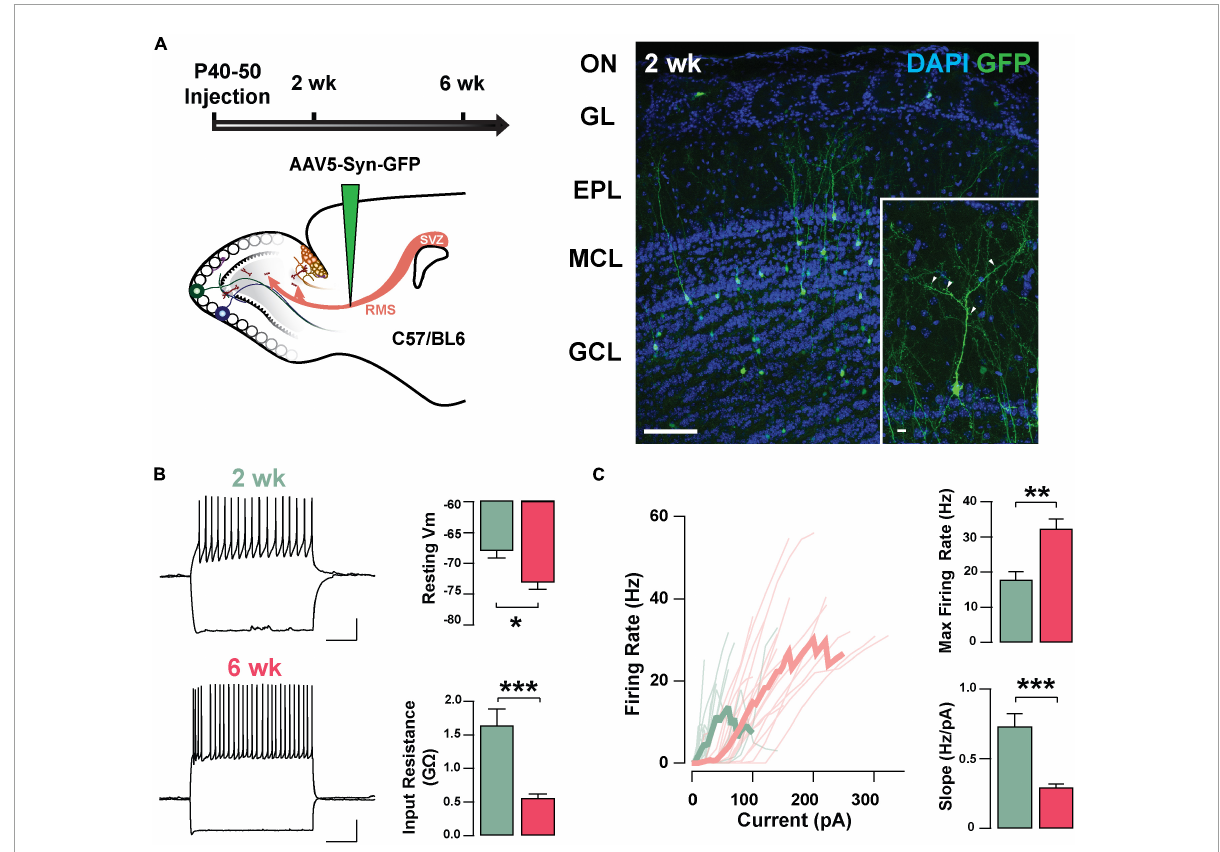
FIGURE1 Intrinsic physiological properties of adult-born GCs. (A) Left: diagram of strategy used for labeling abGCs. Adult-born neurons were labeled with GFP at 40–50 days postnatal (p40–50) using virus-mediated transduction. We examined GC properties at 2 and 6 weeks (week) post-injection. Right: Confocal images of GFP-labeled adult-born neurons (green) in the MOB at 2 weeks post-injection. The inset shows a mature GC with a primary apical dendritic branch and abundant dendritic spines (arrow heads). OB cell layers, indicated on the left, were determined using DAPI (blue). Calibration: 100 and 10 µ m (inset). (B) Left: traces from representative cells at 2 weeks (green) and 6 weeks (pink) post-injection showing responses to square current steps (–120 to +260 pA). The resting membrane potential (Vm) was –63 and –78 mV, respectively. The voltage traces show sustained action potentials in response to positive current injections and a small sag with negative current injections. The calibration is 20 mV and 500 ms. Right: bar graphs summarizing changes in GC excitability at two stages of cell maturation (2 weeks, n = 16 cells; 6 weeks, n = 18 cells). From 2 to 6 weeks post-injection, abGCs show a decrease in resting Vm (* p = 0.003), and a decrease in the input resistance (** p = 0.0001). (C) Left: input-output curves for firing rates elicited by a range of 2 s square current pulses. Right: Cells at 6 weeks post-labeling exhibited a higher maximal firing rate (** p = 0.0005), and lesser slope in their input-output function (*** p = 0.00003).